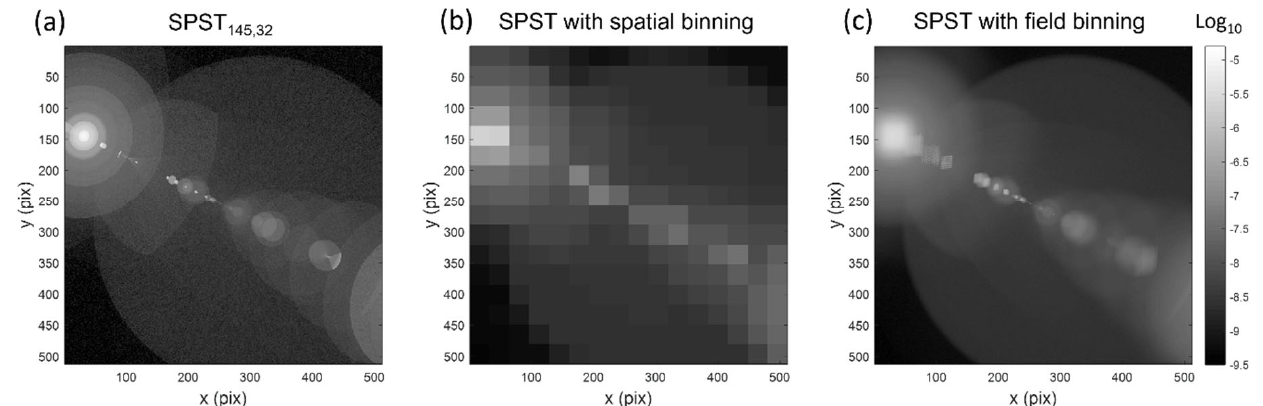
Figure 4. ( a ) SPST 145,32 at the resolution of the detector array (512 × 512). ( b ) Spatial binning reduces the dimension of the map to n × n with n = 16. ( c ) Field binning averages the SPST for adjacent fields ( m = 16) but keep unchanged the resolution.